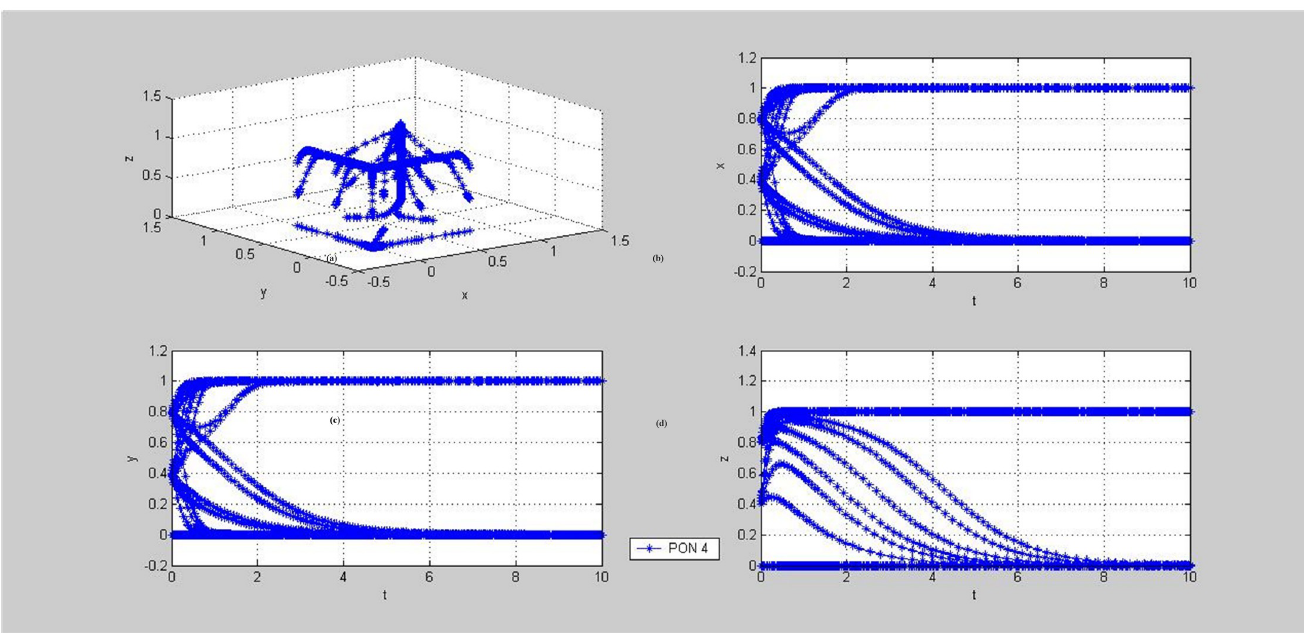
Fig 9. Evolutionary dynamics of mixed strategies (cooperation, cooperation, non-supervision) or (betrayal, betrayal, supervision). PON-Proposition. (a)~(d) demonstrate the phase trajectories of x, y, z and (x, y, z) in the game situations shown in Proposition 4: (a) The phase trajectory of (x, y, z) of the entire evolutionary game system over time t; (b) the dynamic evolution characteristic of x, i.e., the proportion of individuals choosing Cooperation strategy in population PPP over time t; (c) the dynamic evolution characteristic of y, i.e., the proportion of individuals choosing Cooperation strategy in population DC over time t; (d) the dynamic evolution characteristic of z, i.e., the proportion of individuals choosing Non-supervision strategy in population TPIP over time t.